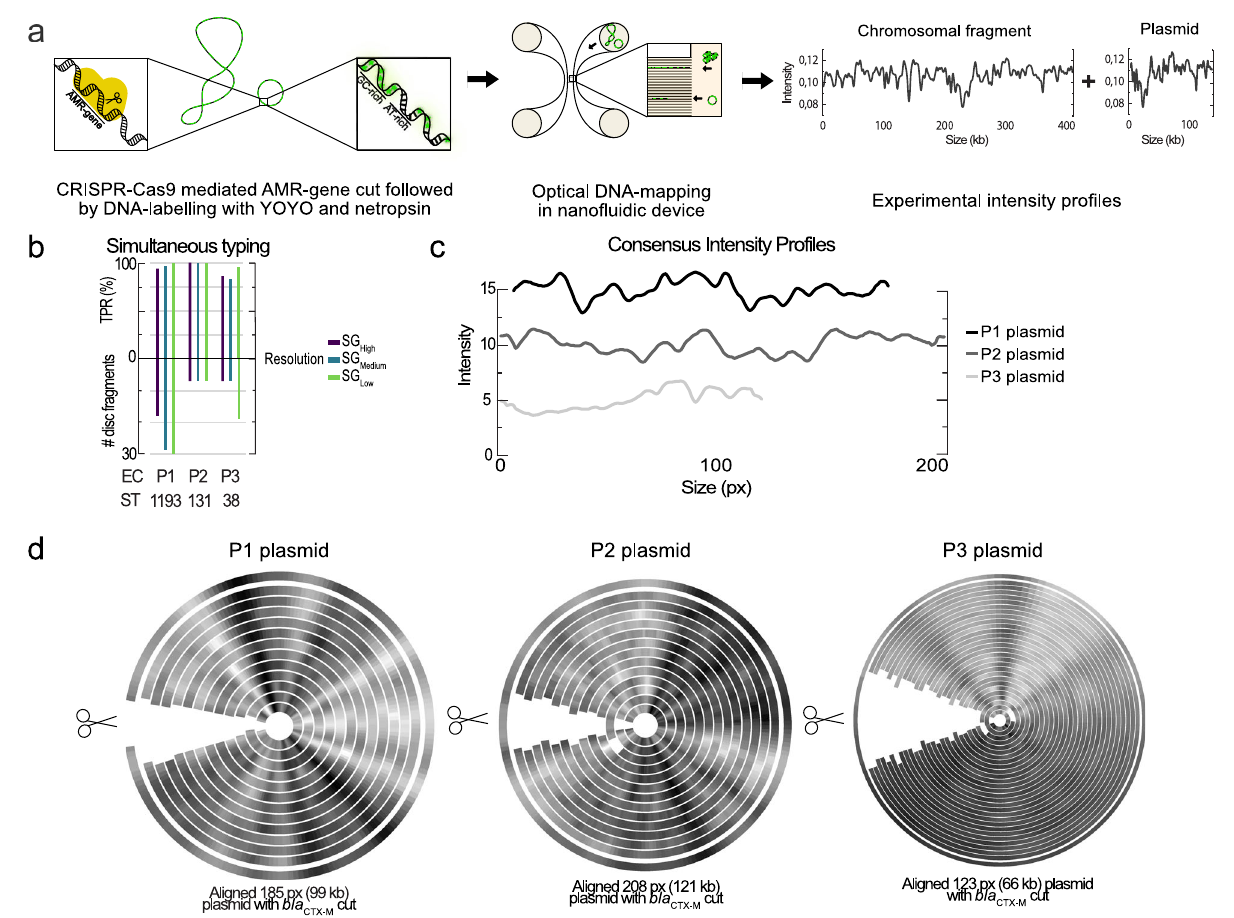
Fig. 4 Simultaneous bacterial typing and plasmid characterization. a Experimental pipeline. DNA is extracted via plug-lysis and the gene of interest is cut by Cas9 followed by YOYO-1 and netropsin labelling. The labelled DNA sample, containing both chromosomal and plasmid DNA, is con fi ned to nano fl uidic channels and imaged using a fl uorescence microscope, resulting in one experimental intensity pro fi le per DNA fragment. b Bacterial typing using pro fi les longer than 250 pixels (~135 kb). The bar charts show the true positive rate (TPR) and the number of discriminative intensity pro fi les for samples P1, P2 and P3 at the three strain group (SG) resolutions, SG High , SG Medium and SG Low . c The intensity pro fi les for the consensuses from the plasmids from P1, P2, and P3 shifted vertically for clarity. d Detection of plasmid-borne bla CTX -M group 1 and 9 genes. In the circular plot, each ribbon represents individual DNA fragments and their brightness corresponds to the intensity pro fi le. The pro fi les have been aligned and the consensus of all the pro fi les is included as the outermost ribbon. Linearization at the same position indicates a cut by Cas9 and veri fi es the presence of the target gene (see examples of randomly linearized in Supplementary Fig. 3). The three circular plots show linearization by Cas9 for the 99 kb plasmid in sample P1 (12/12 pro fi les linearized at the same position), 121 kb plasmid in sample P2 (12/13) and for the 66 kb plasmid in sample P3